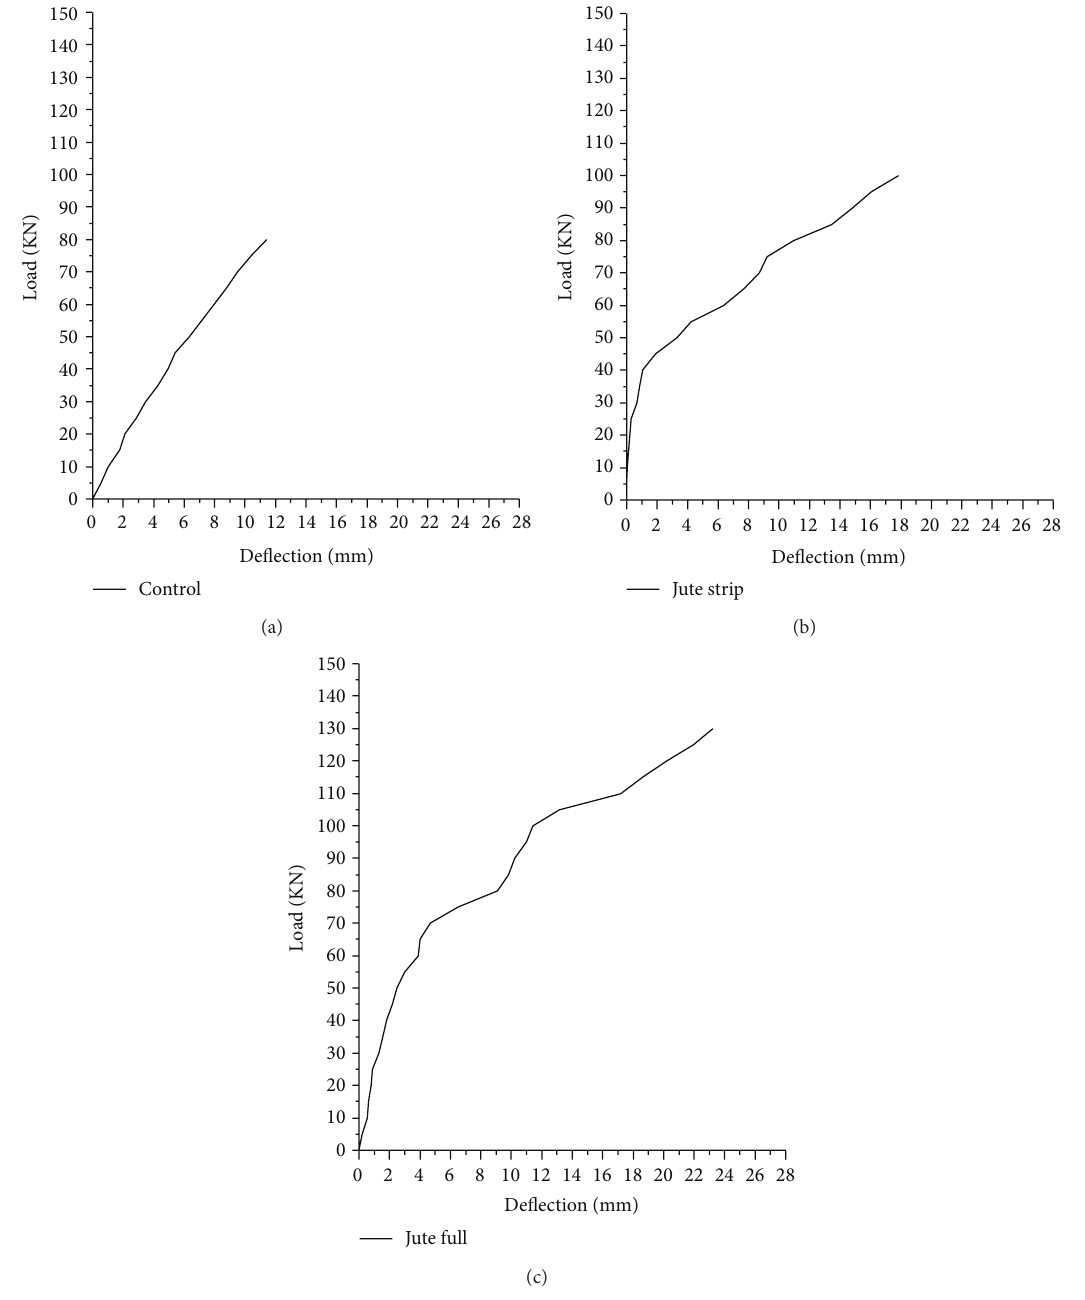
Figure 8: Load versus midspan deflection of (a) Control; (b) woven jute FRP strip wrapped beams; (c) woven jute FRP fully wrapped